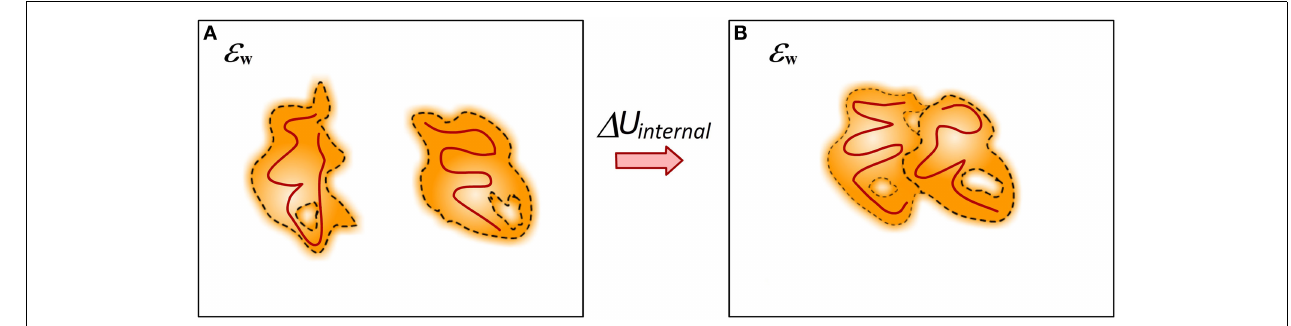
FIGURE 7 | Cartoon presentation of the conformational changes caused by the binding. (A) Monomers; (B) Complex. Different structures of bound and unbound molecules will have different